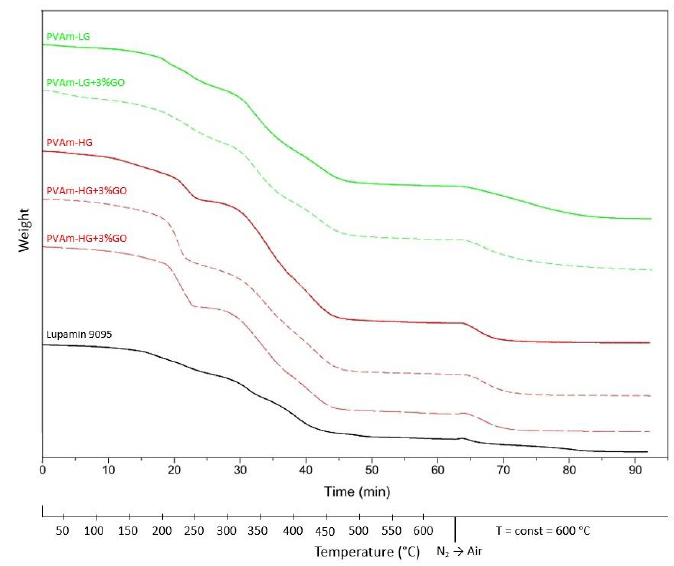
Figure 6. TGA curves of Lupamin 9095 and PVAm films at different degrees of purification, with and without G and GO.